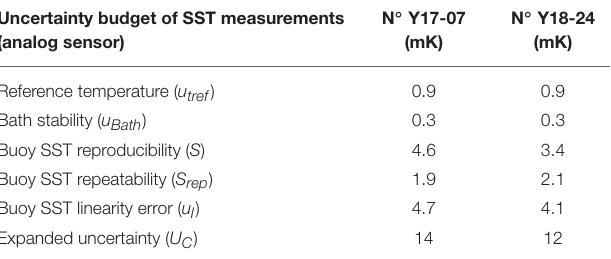
TABLE 5 | Uncertainty budget of buoys SST measurements in the range 6–35 ◦